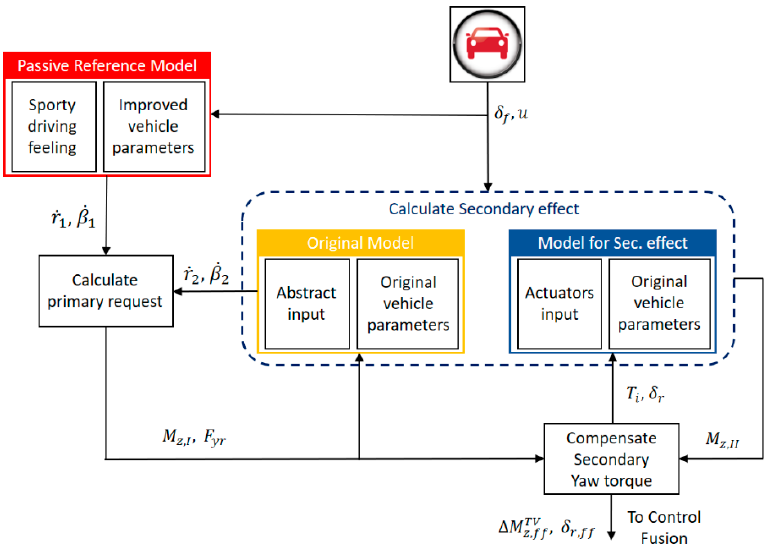
Figure 7. Block diagram of the feedforward controller.